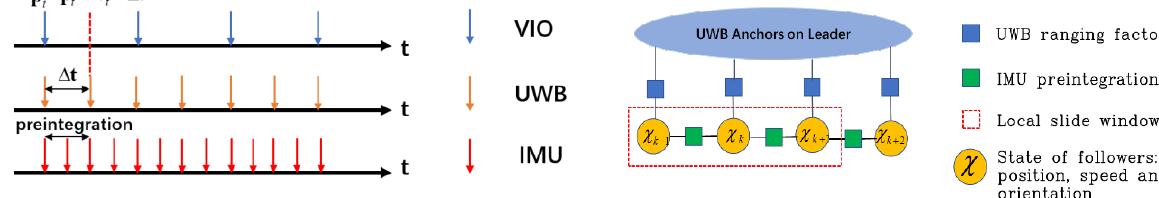
Figure 3 . We use first-order linear interpolation between VIO and UWB and preintegrate the IMU between UWB ranging. Figure 4. Factor graph model of Follower . UWB provides ranging factors and IMU provides preintegration